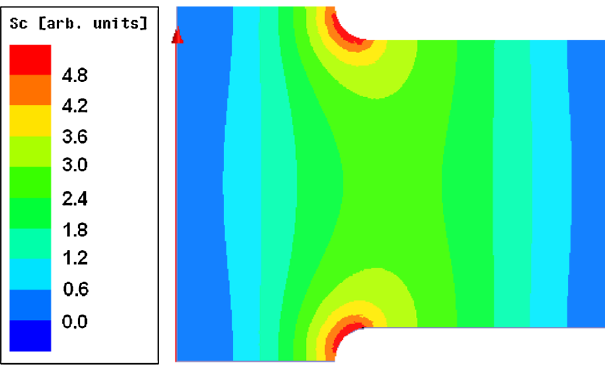
FIG. 11. (Color) Dependence of the weighting factor g local electric field (cid:2)E 0 .